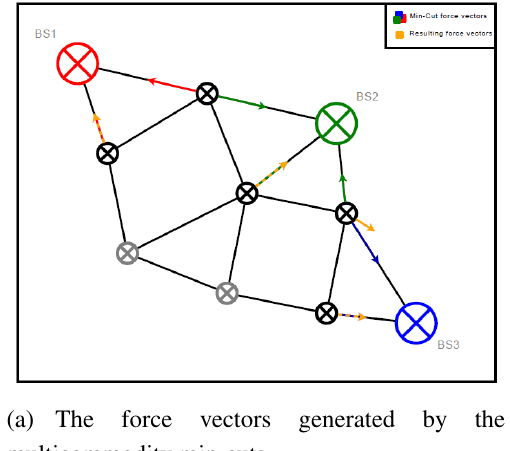
Figure 8. Force vectors from multicommodity min-cut